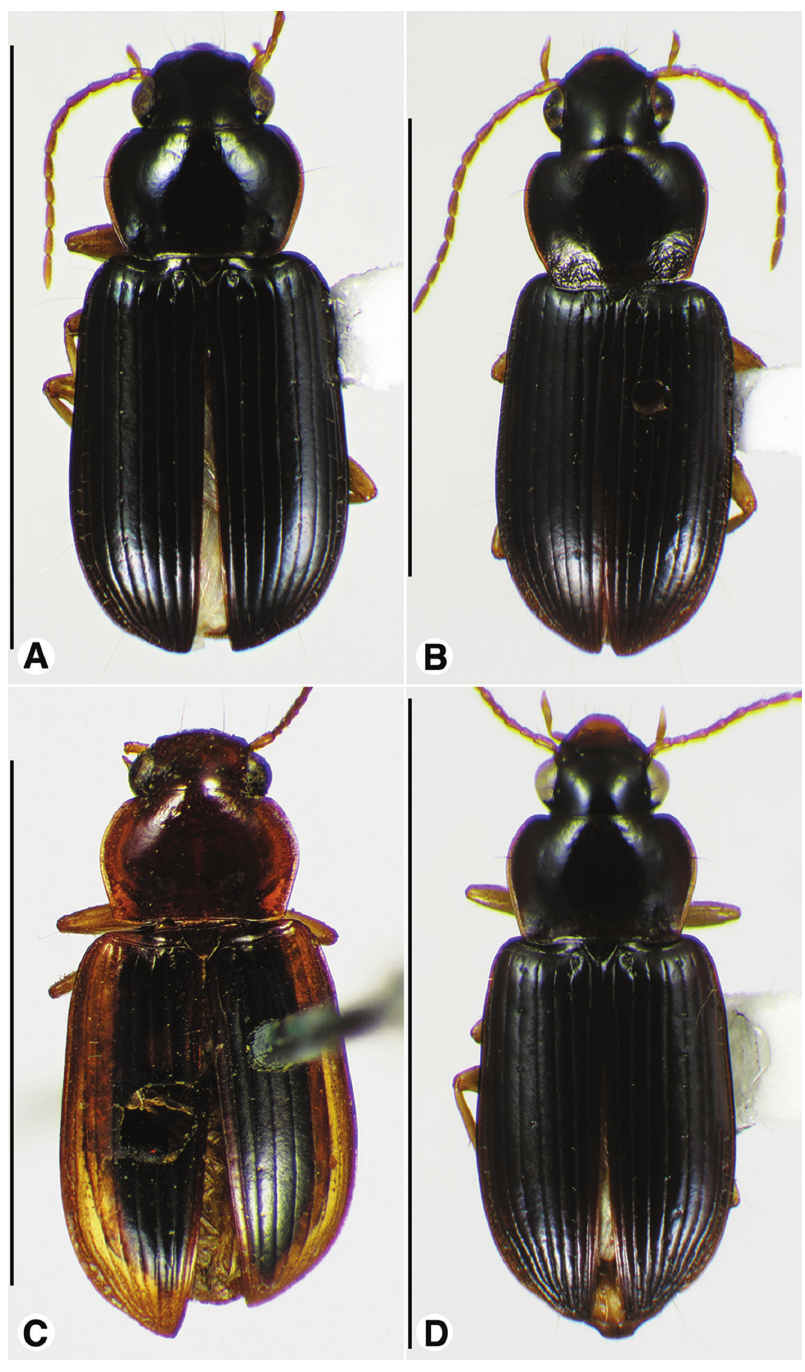
Figure 25. Habitus digital images of Selenophorus hylacis species group, in part, dorsal aspect. A S. clypealis Ball & Shpeley B S. dessalinesi Ball & Shpeley C S. dubius Putzeys D parvus Darlington. Scale bars 5